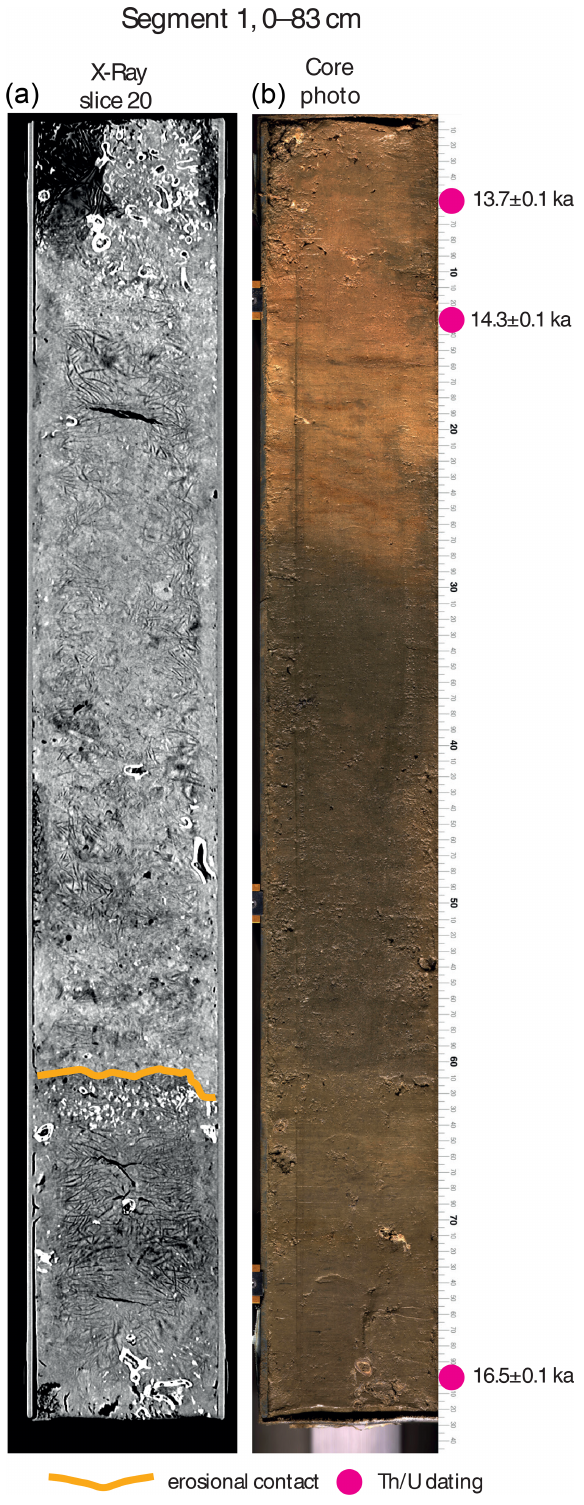
Figure A1. CT image (a) and photography (b) of segment 0–83cm of core M125-34-2. Erosional contacts are marked by thick black lines; position of Th / U datings with calibrated ages are indicated by magenta